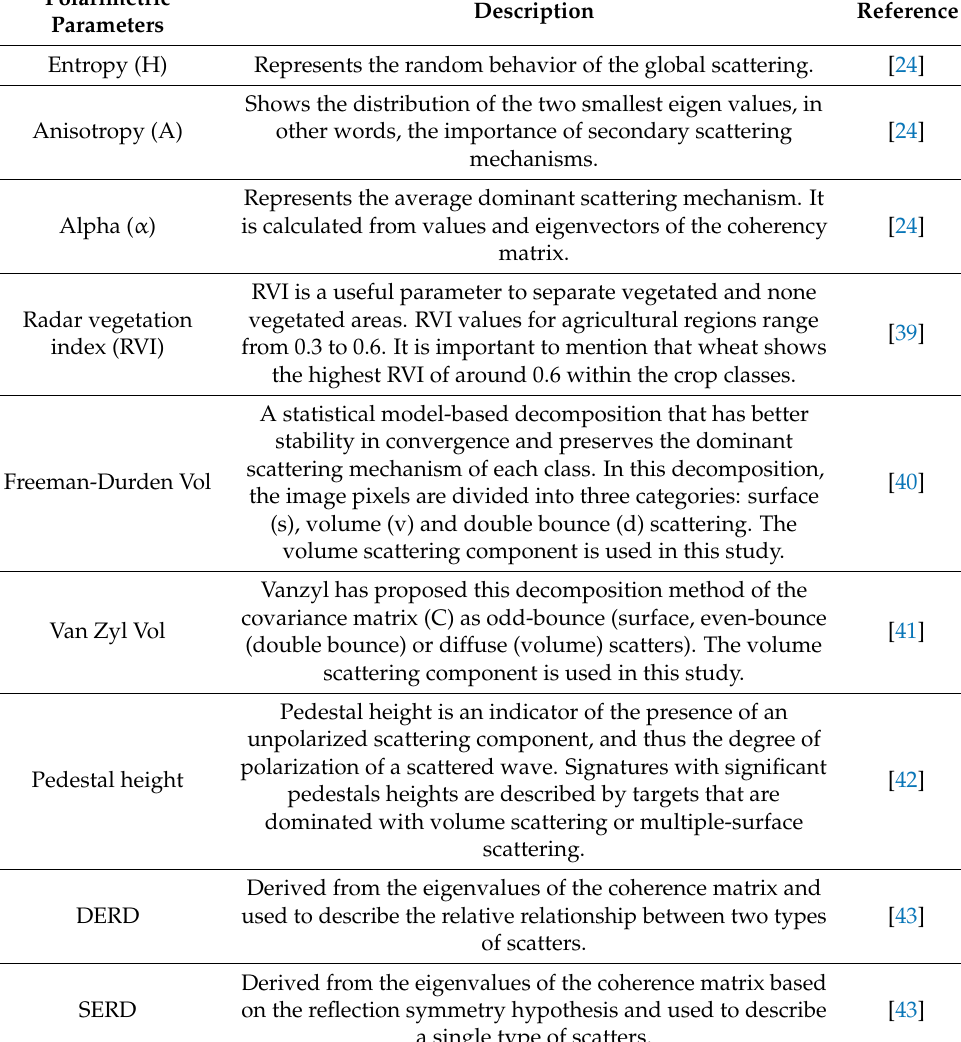
Table 2. Description of the polarimetric parameters